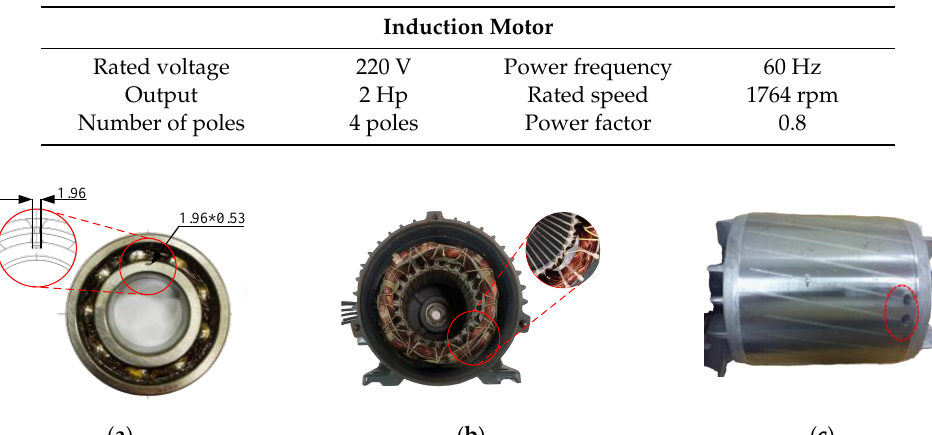
Table 1. Specification of the induction motor.